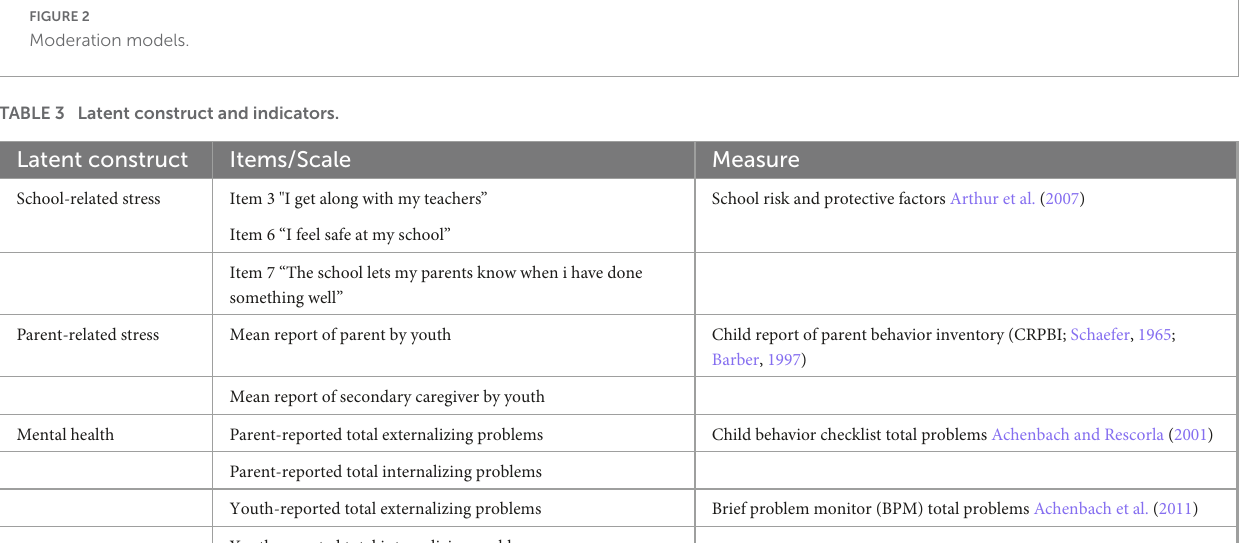
FIGURE2 Moderation models.